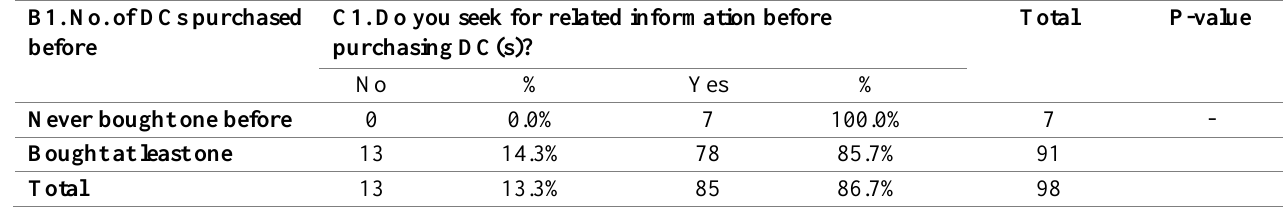
Table 2. Result For Hypothesis 1